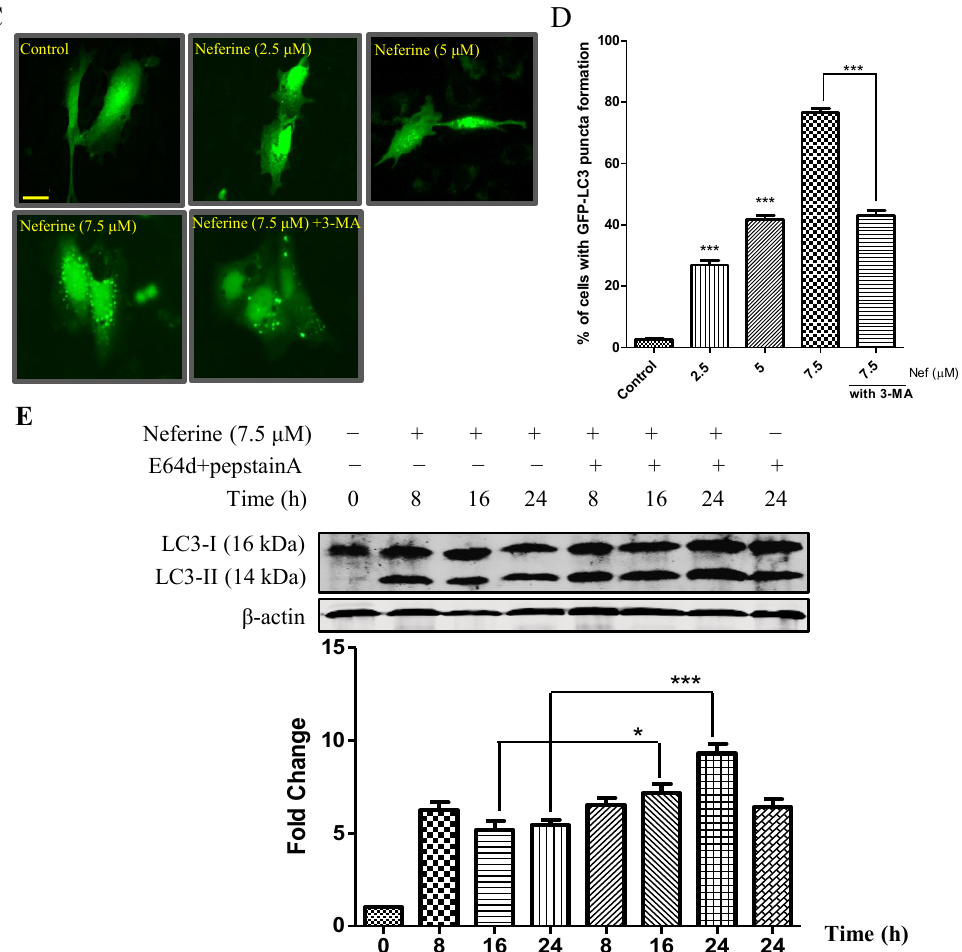
Figure 1. Neferine induces autophagy. ( A ) Chemical structure of neferine. ( B ) Cell viability was measured at 48 h after treatment with neferine. The IC 50 value (12.8 µM) of neferine was determined graphically from the survival curve. ( C ) PC-12 cells transfected with GFP-LC3 plasmids were incubated with neferine (0 to 7.5 µM) with or without the presence of 3-methyladenine (3-MA, 5 mM) for 12 h. Representative images demonstrated that the number of LC3-positive cells was smaller after 3-MA treatment. Magnification: ×40. Scale bar: 15 µm. ( D ) Quantitation on the percentage of cells with GFP-LC3 puncta formation. ( E ) PC-12 cells were treated with neferine with or without the presence of E64d and pepstatin A (lysosomal protease inhibitors, 10 µg/mL) for 0 to 24 h. The level of LC3 II expression (14 kDa) was significantly higher after neferine treatment with the presence of lysosomal protease inhibitors. LC3-II band intensities were quantified using densitometric analysis and normalized to β-actin. Data are expressed as the fold change relative to the DMSO-treated negative control. Bars: SD. *** p < 0.001; * p < 0.05.